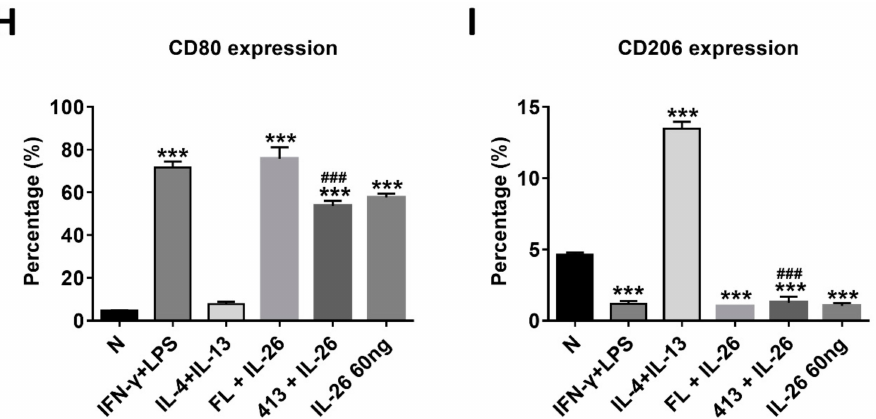
Figure 1. E ff ect of IL-26 on M1 and M2 macrophage di ff erentiation in RAW264.7, BMDM, and THP-1.